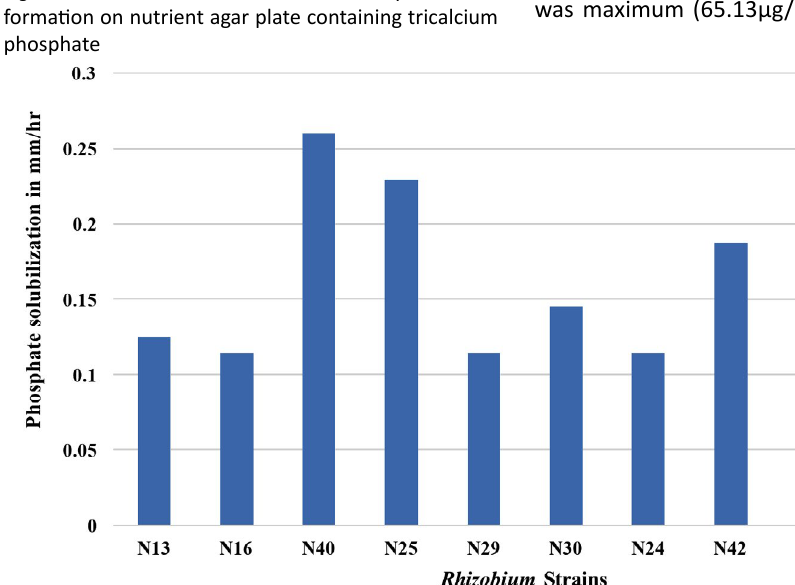
Fig. 5. Phosphate solubilization of Rhizobium leguminosarun bv . viciae strains